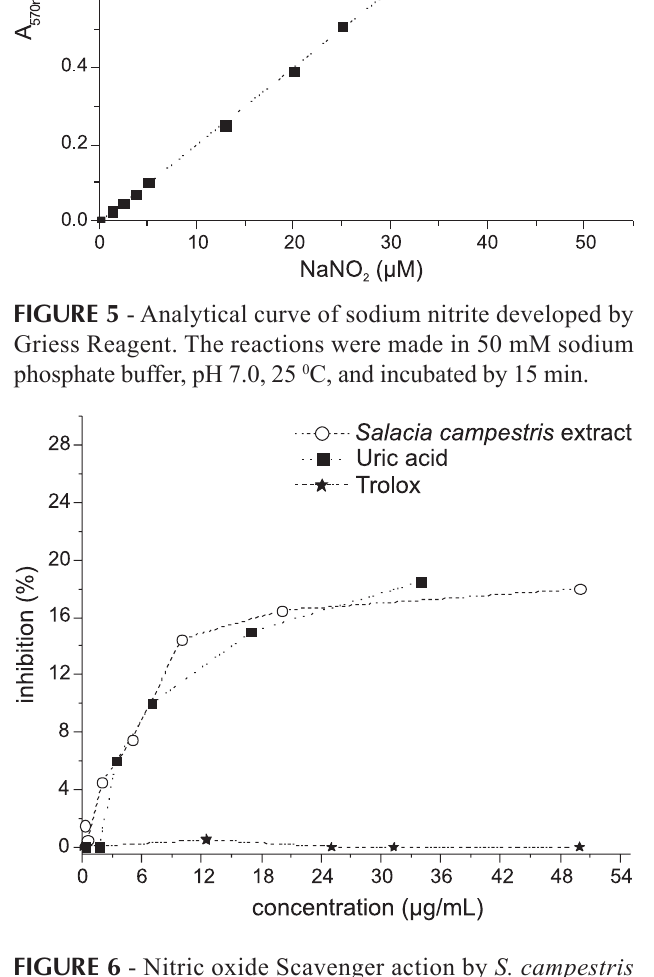
FIGURE 6 - Nitric oxide Scavenger action by S. campestris extract, uric acid and trolox. The reactions were made in 50 mM sodium phosphate buffer, pH 7.0, 25 0 C, and incubated by 90 min before reaction with Griess